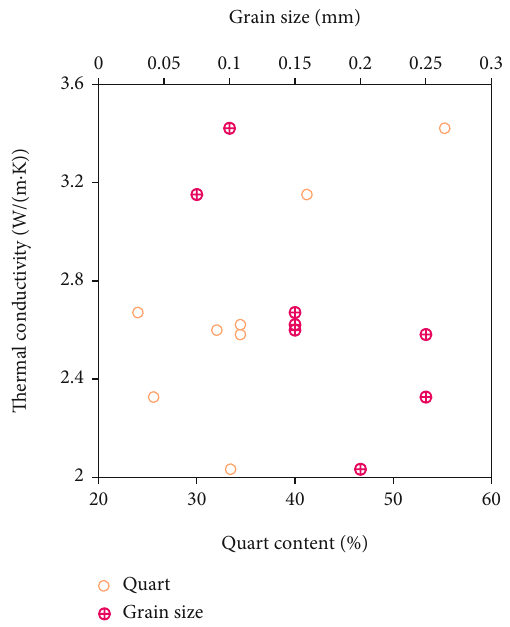
Figure 15: Thermal conductivity of sandstone with varying quartz content and grain